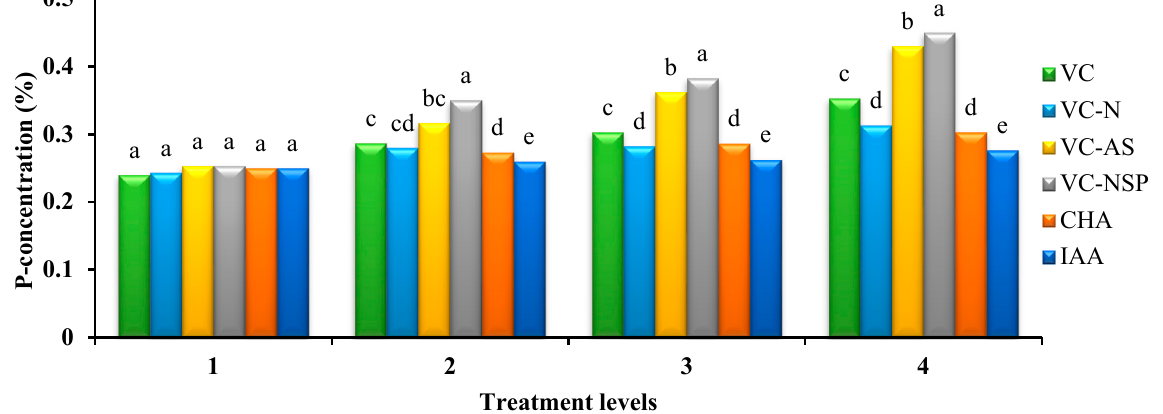
Figure 7. Comparison of average soil application of experimental treatments on P-concentration at treatment levels (levels 1, 2, 3 and 4 for VC, VC-N, VC-AS and VC-NSP treatments of 0, 1, 2 and 3% VC, 0, 200, 400 and 600 mg of CHA per kg of soil and 0, 10 − 6 , 10 − 5 and 10 − 4 molar IAA). Different letters in each figure show significant difference at p ≤ 0.05 by Duncan multiple range test. VC, VC without enrichment; VC-N, VC enriched with 1% nitrogen; VC-NSP, VC enriched with 1% nitrogen, 1% sulfur, and 1% phosphorus; VC-AS, VC enriched with Azotobacter chroococcum (21Az) + Pseudomonas fluorescens (Ps 59); CHA, Commercial humic acid; IAA, Indole-3-acetic acid.